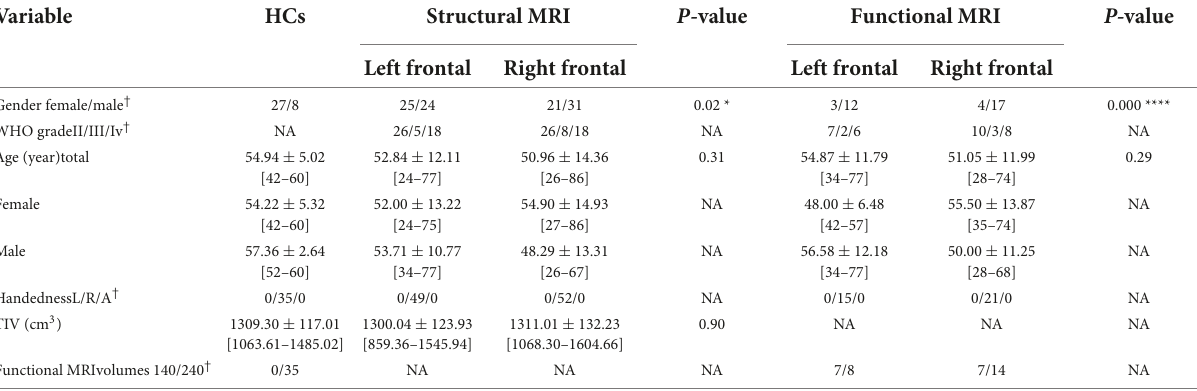
TABLE 1 Demographic and clinical